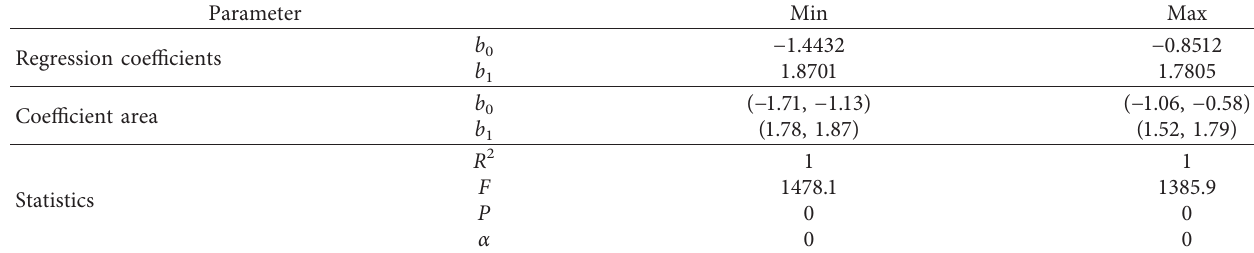
Table 1: Parametric regression analysis results for uniform